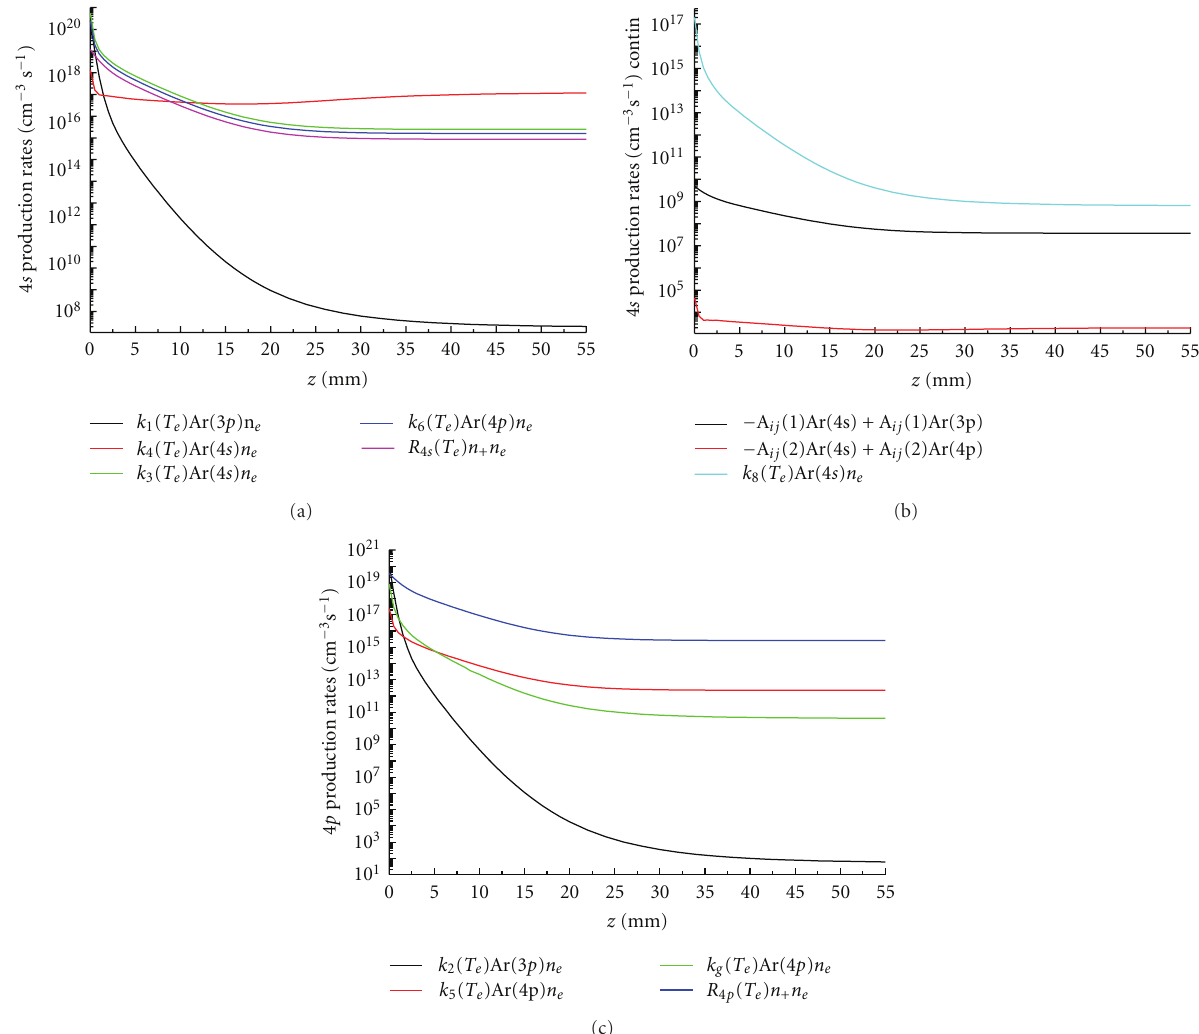
Figure 14: Production rates of Ar(4 s ) and Ar(4 p ) along the divergent part axis for I =